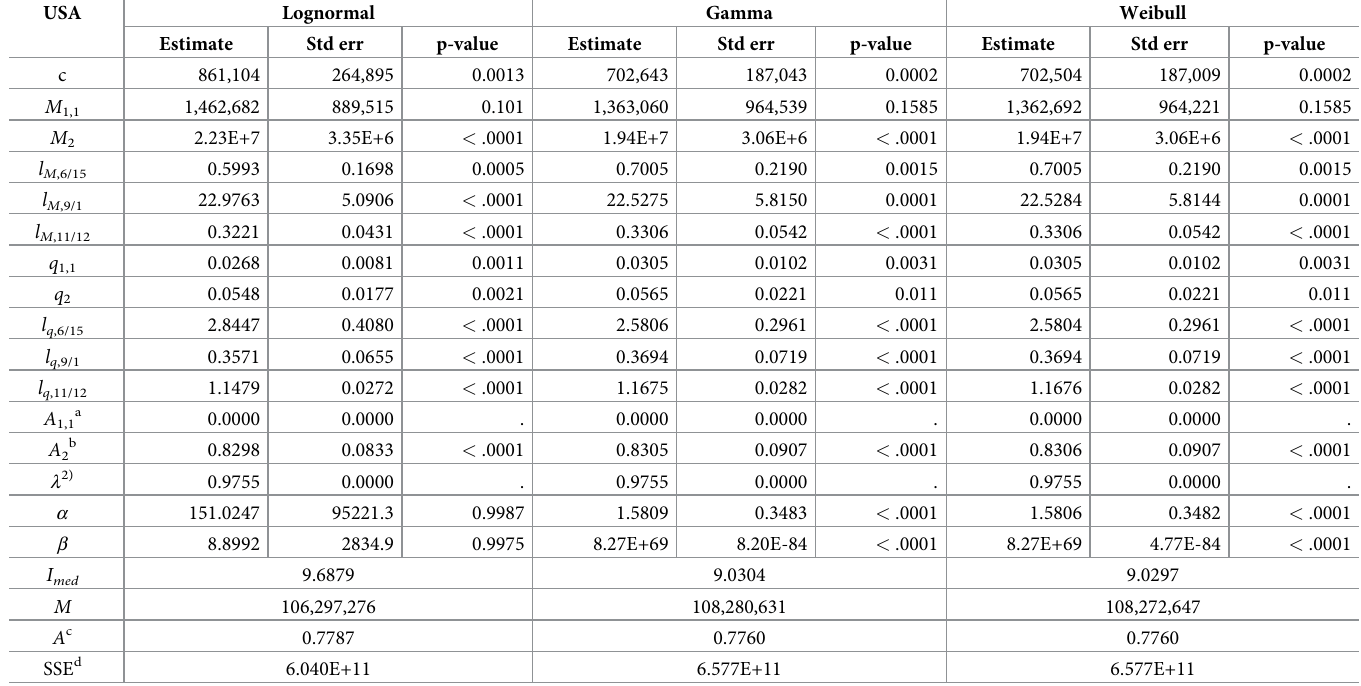
Table 4. Comparison of model fit and parameter estimates for confirmed cases in the United